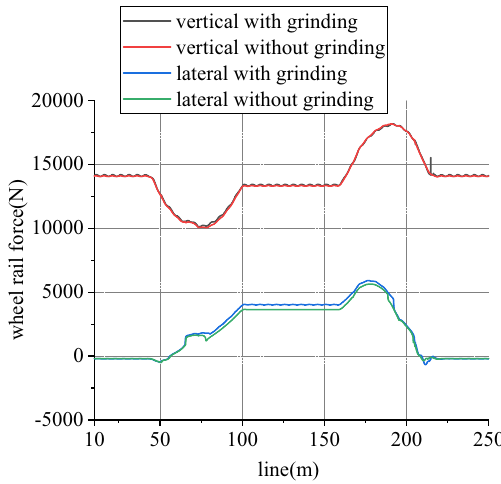
Figure 15. Wheel rail force of right wheel in front wheelset (typical case).